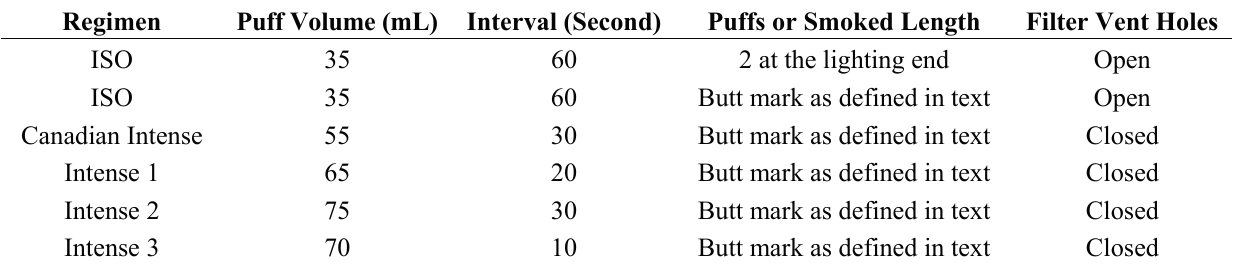
Table 1. Machine smoking regimens used to establish correlation relations